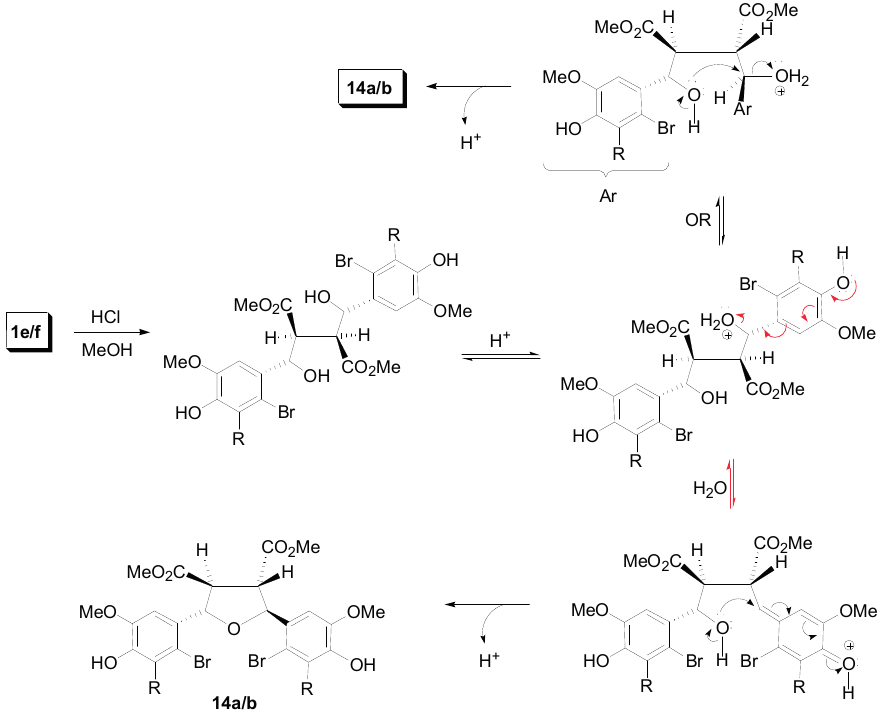
Scheme 10. A plausible mechanism for the conversion of dilactones 1e / 1f to tetrahydrofuran derivatives 14a / b on treatment with HCl/MeOH.